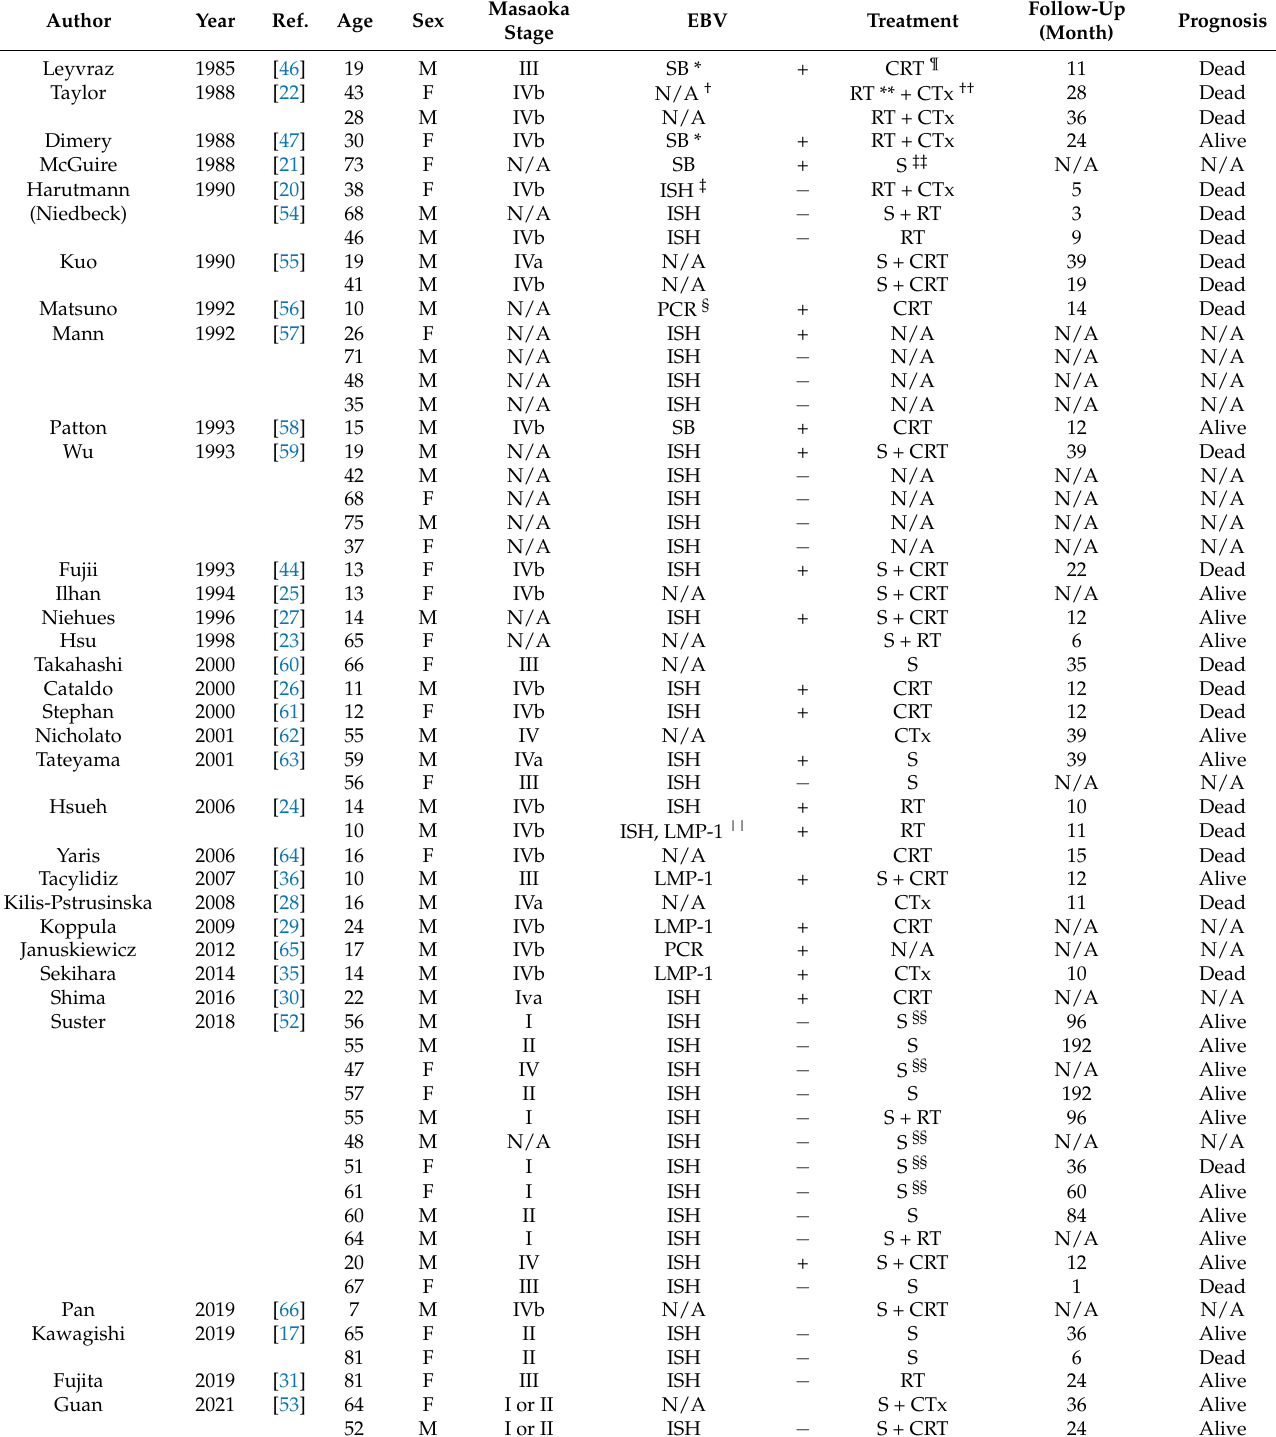
Table 1. Details of reported